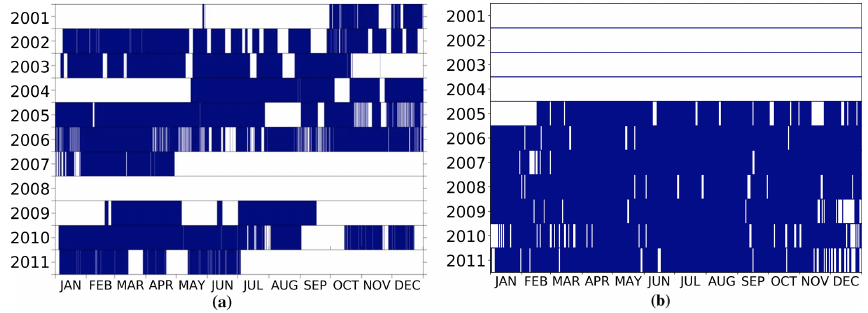
Figure 4. Availability of meteor radar observations for (a) Ascension Island (from Davis et al., 2013) and (b) Rothera. This motivates the choice of 2006 as the year for comparison.